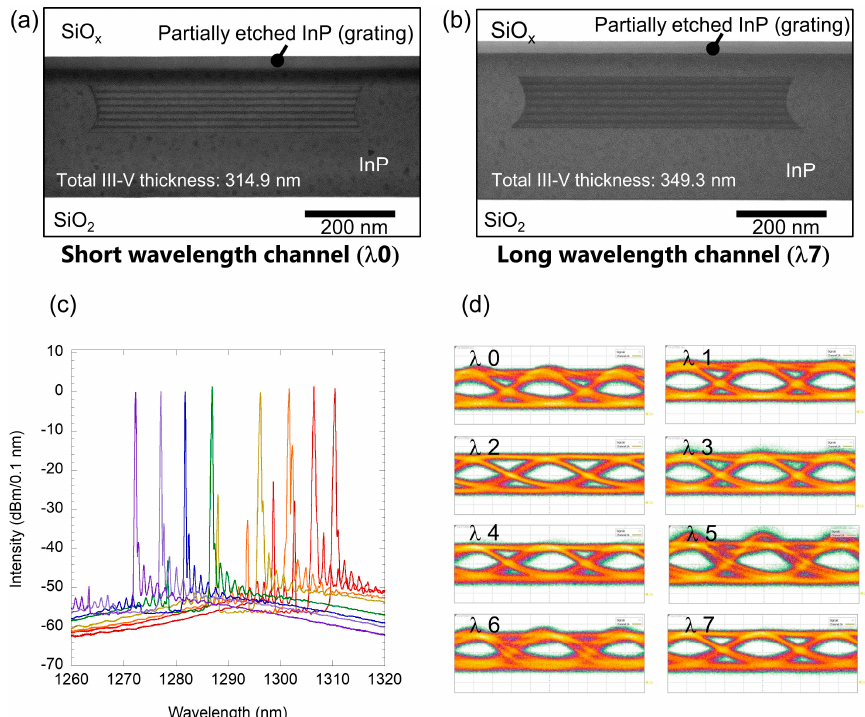
Figure 14. ( a , b ) Cross-sectional BF-STEM image of selectively grown lasers on Si substrate for shortest wavelength channel and longest wavelength channel; ( c ) lasing spectra of eight-channel membrane lasers with bias currents from 15 to 23 mA; ( d ) eye diagrams for eight-channel membrane lasers directly modulated with a 25.8-Gbit/s NRZ signal at 25 °C.